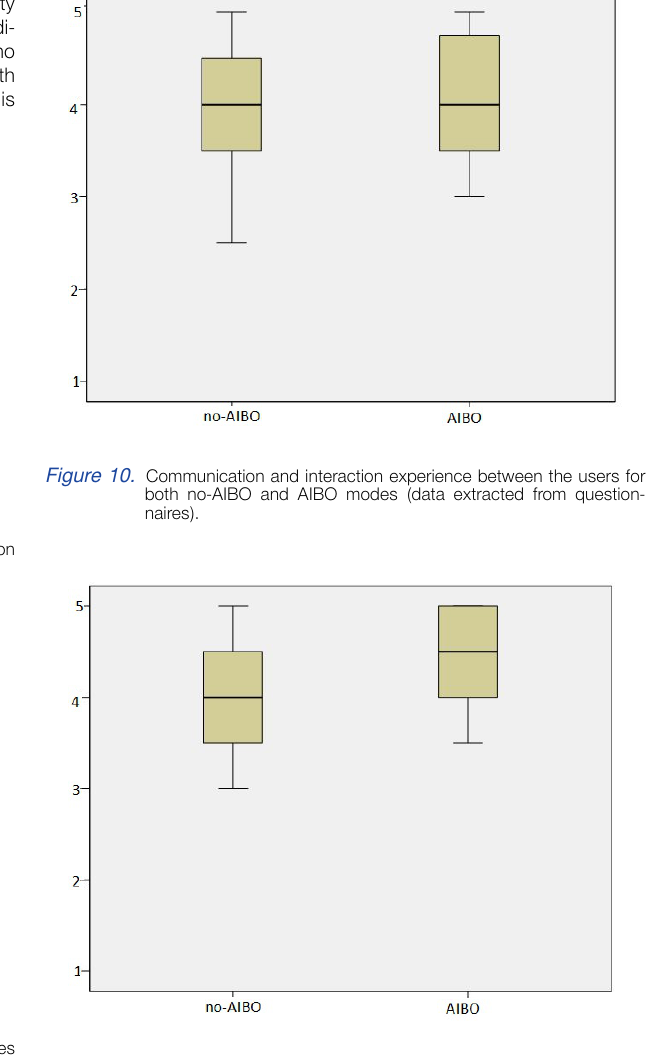
Figure 11. Overall communication experience for both no-AIBO and AIBO modes (data extracted from